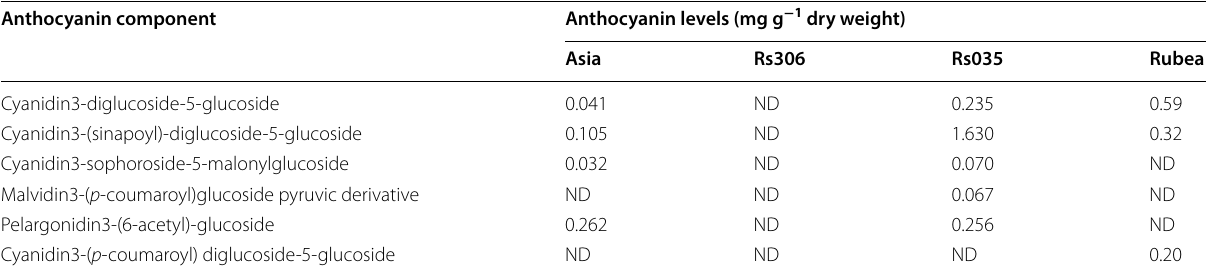
Table 1 Anthocyanin composition in leaves of B. rapa reddish line Asia (A-genome), resynthesis green B. napus line Rs306, resynthesis red B. napus line Rs035 and B. oleracea red cabbage line Rubea (C-genome) as detected by